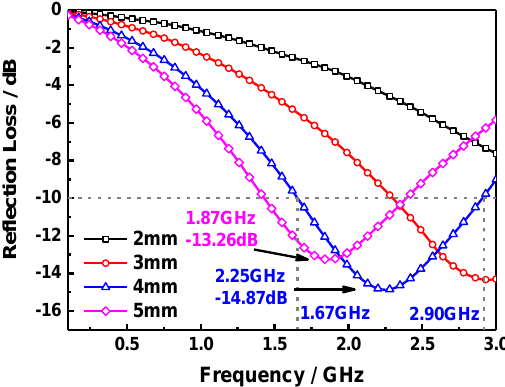
Figure 4. Frequency-dependent reflection loss (RL) curves of S1, S2, S3, and S4 at the thickness of 5 mm.